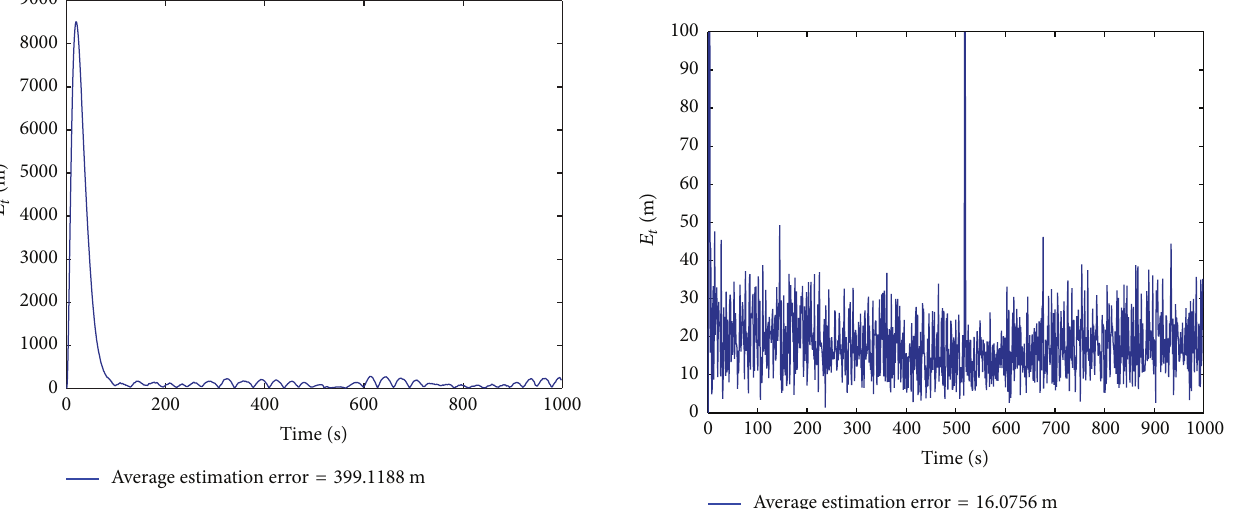
Figure 17: Estimation error of 𝛼 - 𝛽 - 𝛾 filter with 𝑔 𝑟,1 = 𝑔 𝑝,1 = 𝑔 2 = 0.9 .